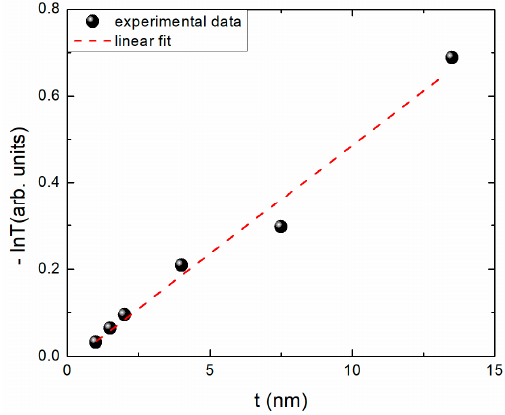
Figure 6. ( − ln T ) as a function of film thickness t . The slope of the linear fit is equal to the absorption coefficient. The transmittance T data have been recorded at 5 eV (250 nm).